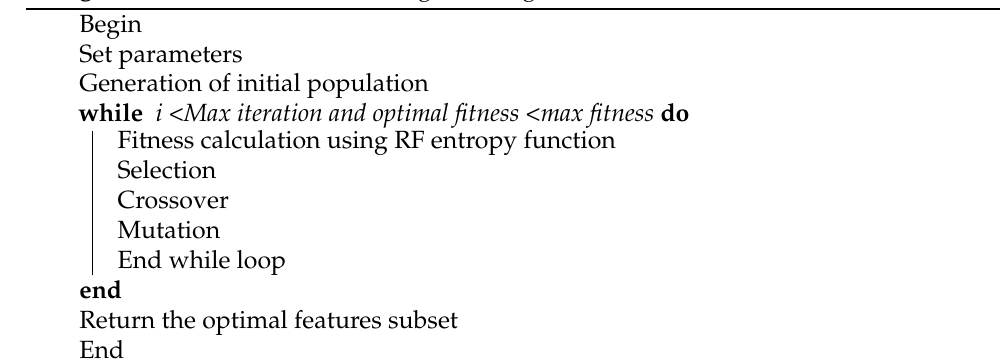
Algorithm 1: Pseudocode of the genetic